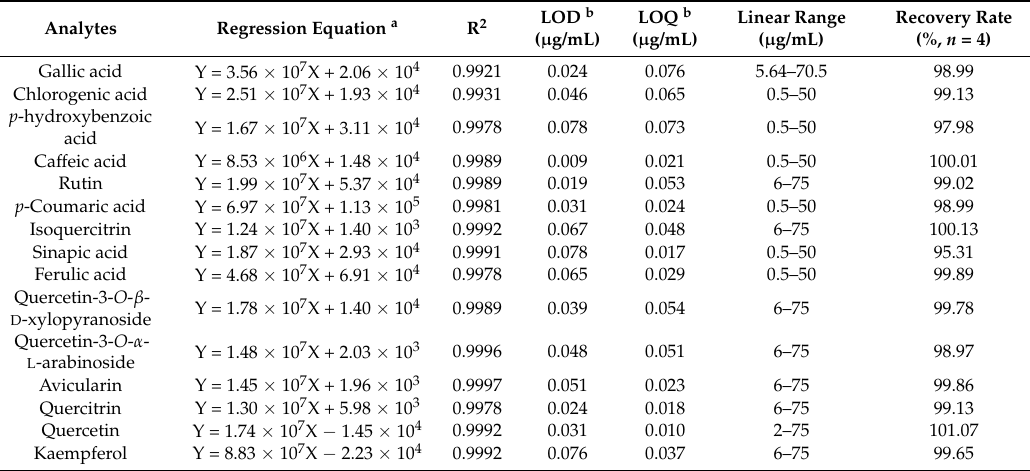
Table 3. Regression equation, R 2 , LOD, LOQ, linear range, and recovery rate analysis results of all phenolics